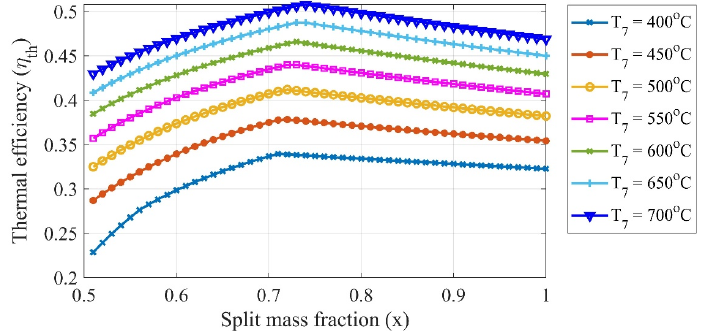
Figure 4. The thermal e ffi ciency of the sCO 2 cycle at di ff erent turbine inlet temperatures ( T 7